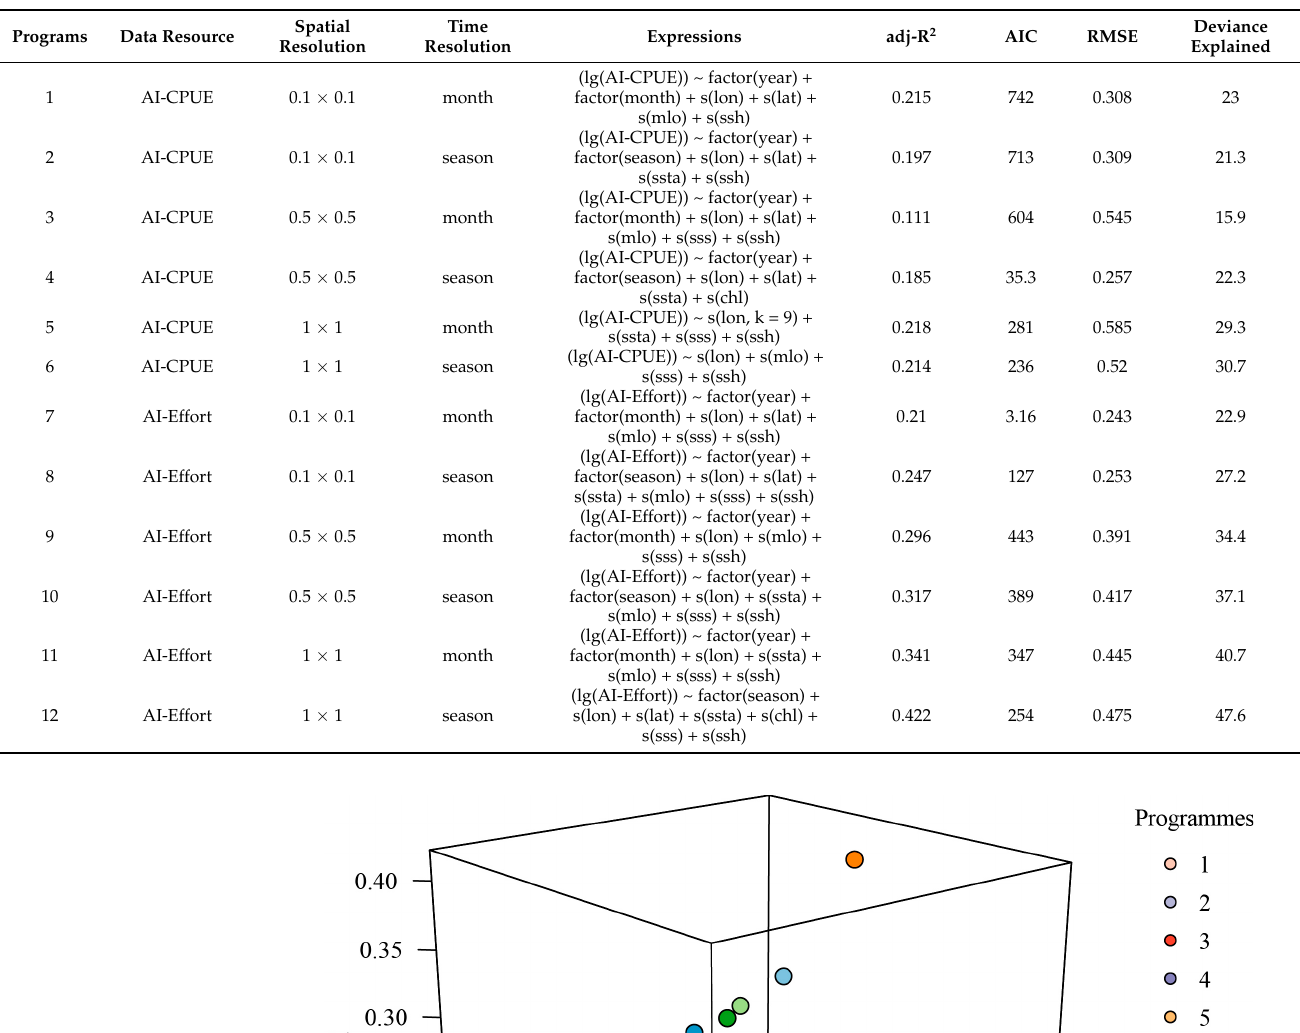
Table 3. Expressions, AIC, adj-R 2 , and 10-fold cross-validated RMSE for GAMs based on 12 spatial and temporal settings.